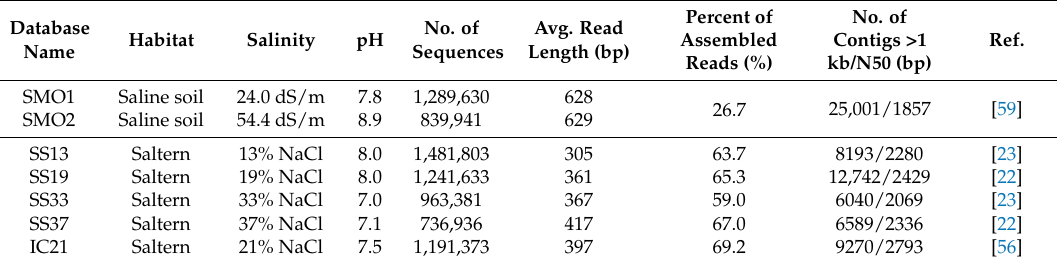
Table 1. Features of the different databases from hypersaline habitats analyzed in this